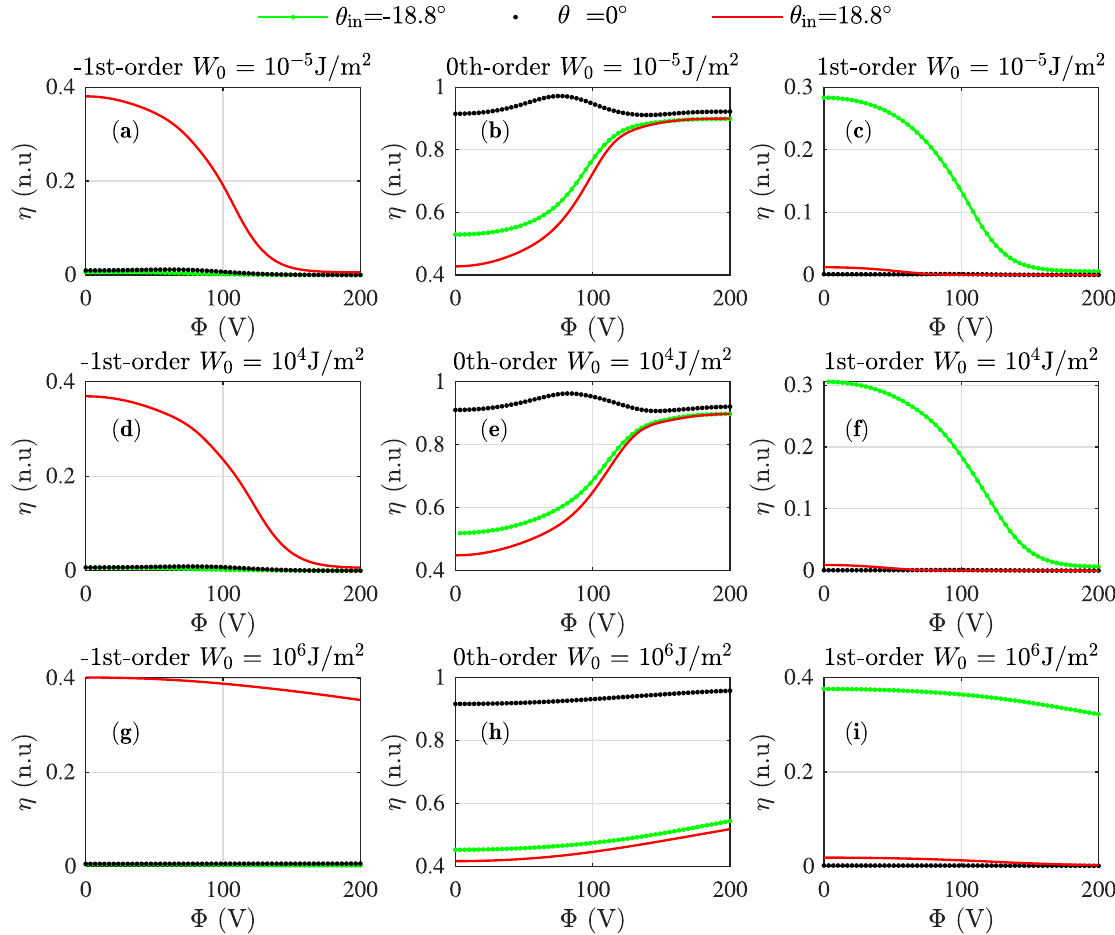
Figure 5. Diffraction efficiencies of ± 1st-order and zeroth-order as a function of the control voltage with anchoring strength W 0 = 10 − 5 J/m 2 and different incidence angles:( a ) -1st-order, W 0 = 10 − 5 J/m 2 . ( b ) 0th-order, W 0 = 10 − 5 J/m 2 . ( c ) 1st-order, W 0 = 10 − 5 J/m 2 . ( d ) -1st-order, W 0 = 10 4 J/m 2 . ( e ) 0th-order, W 0 = 10 4 J/m 2 . ( f ) 1st-order, W 0 = 10 4 J/m 2 .( g ) -1st-order, W 0 = 10 6 J/m 2 . ( h ) 0th-order, W 0 = 10 6 J/m 2 . ( i ) 1st-order, W 0 = 10 6 J/m 2